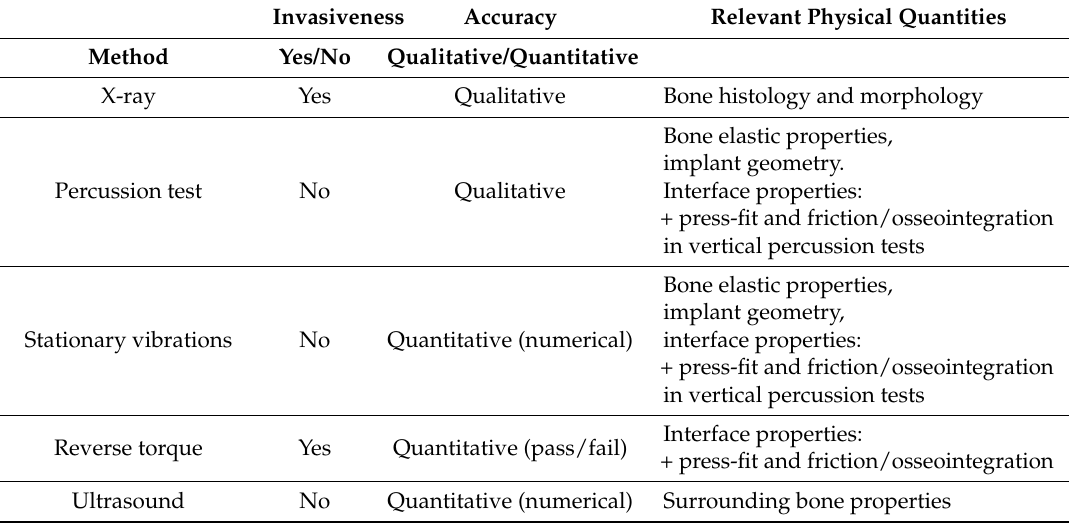
Table 2. Synthetic view of different devices for the assessment of implant